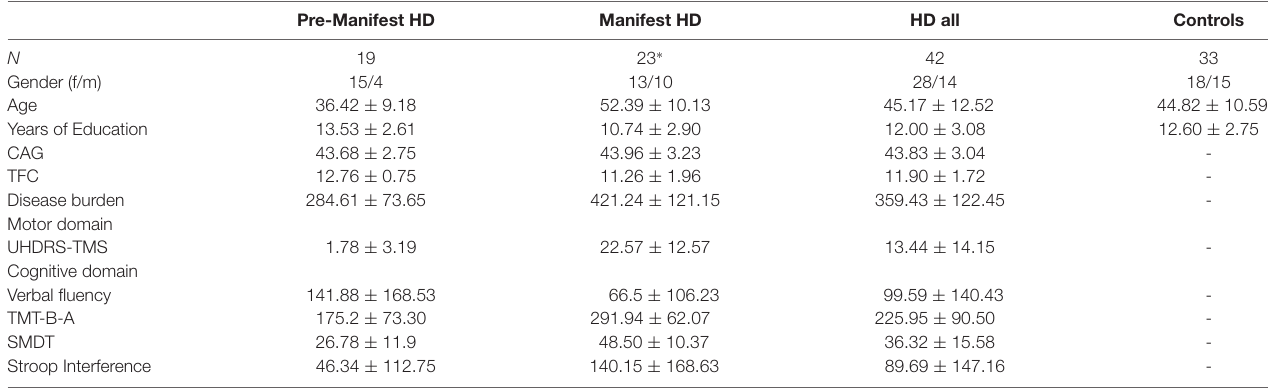
TABLE 1 | Sociodemographic information of HD patients and controls at